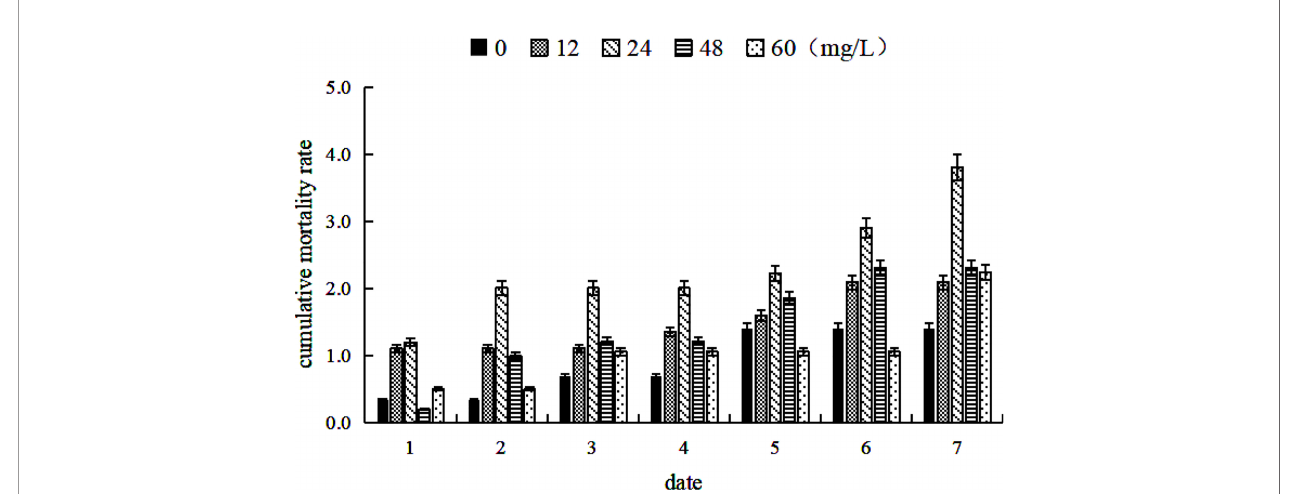
FIGURE 2 | Cumulative mortality of Coilia nasus larvae in the second phase (cultivation with added strontium for 7 d) with different strontium concentrations. Cumulative mortality refers to the sample death as a percentage of total sample